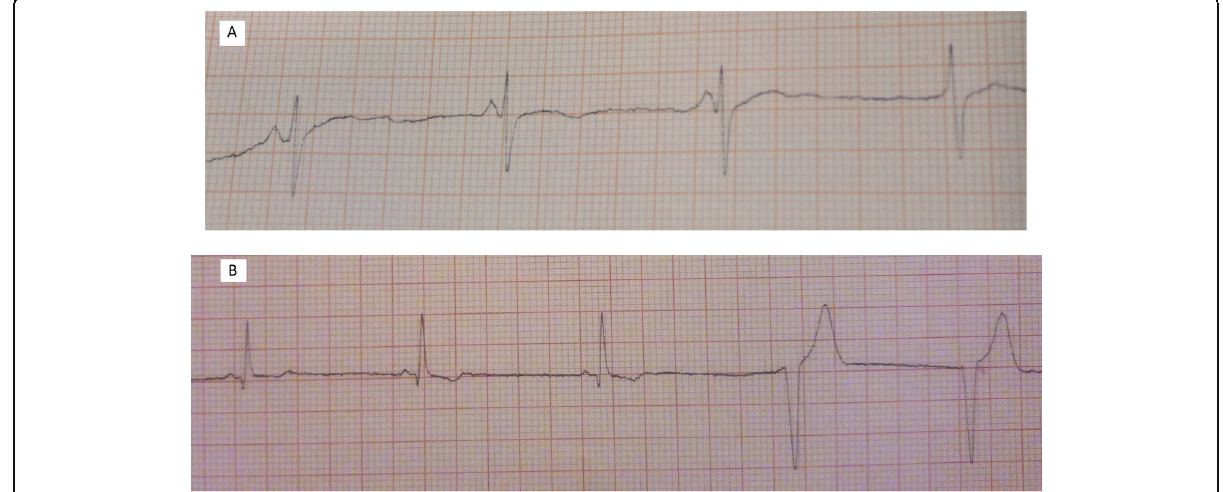
Fig. 5 Transition from sinus rhythm to a nodal rhythm and b idioventricular